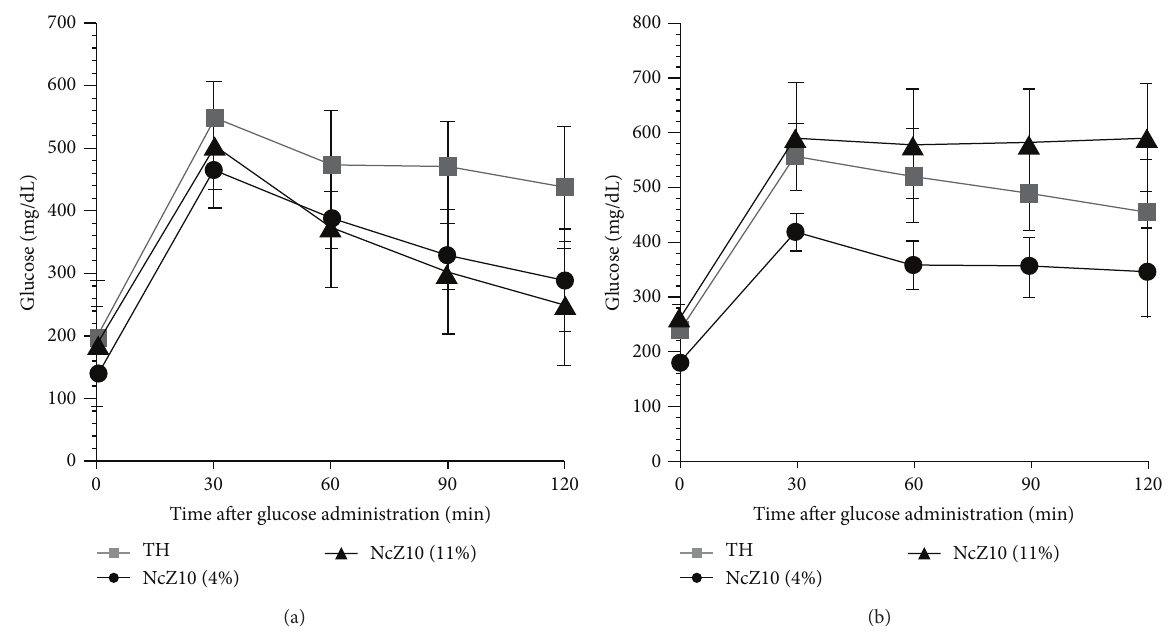
Figure 3: Oral glucose tolerance tests (2g glucose/kg) of TH and NcZ10 males (a) at 8weeks of age and (b) at 24 weeks of age ( 𝑛 = 10 /group). Table 1: Comparison of selected serum analytes in the male cohorts shown in the figures. Data show mean ± SEM for 8–10 males at 20 weeks of age. Lean age-matched BKS males are shown for comparison. Groups were maintained on 6% fat chow except for NcZ10 males that were fed 11% fat chow. Hemoglobin A1c (HbA1c) values are shown to document chronic hyperglycemia in the 3 diabetic stocks. Strain